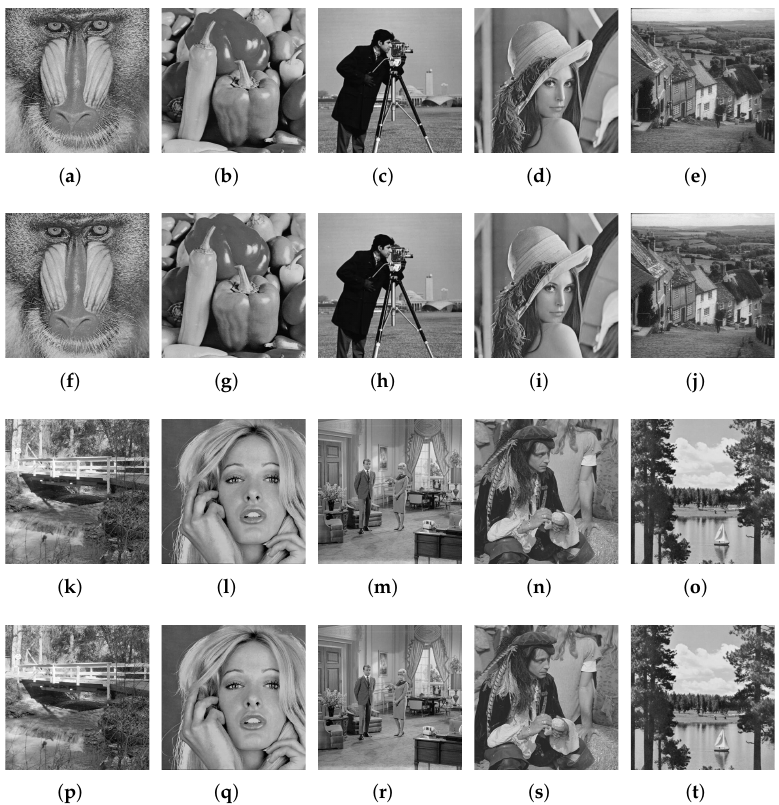
Figure 8. The original images and their corresponding watermarked one. Original images: ( a ) Man- dril, ( b ) Peppers, ( c ) Cameraman, ( d ) Lena, ( e ) Goldhill, ( k ) Walkbridge, ( l ) Woman blonde ( m ) Livin- groom, ( n ) Pirate, ( o ) Lake. Watermarked images: ( f ) Mandril, ( g ) Peppers, ( h ) Cameraman, ( i ) Lena,